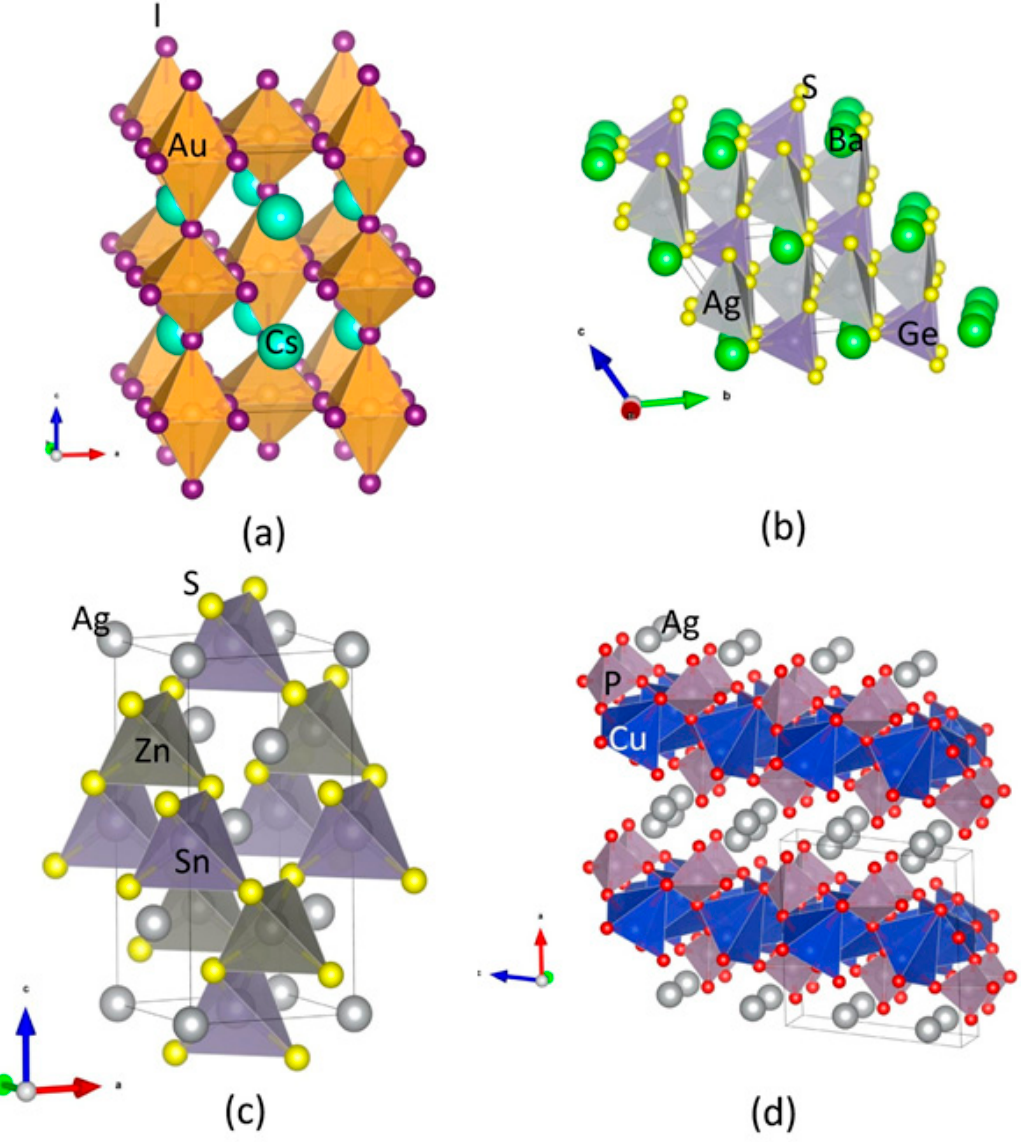
Figure 1. Crystal structures for ( a ) Au 2 Cs 2 I 6 ; ( b ) Ag 2 GeBaS 4 ; ( c ) Ag 2 ZnSnS 4 (in I - 4; kesterite-type); and ( d ) AgCuPO 4 . The legends for the different kinds of atoms shown in the illustration.